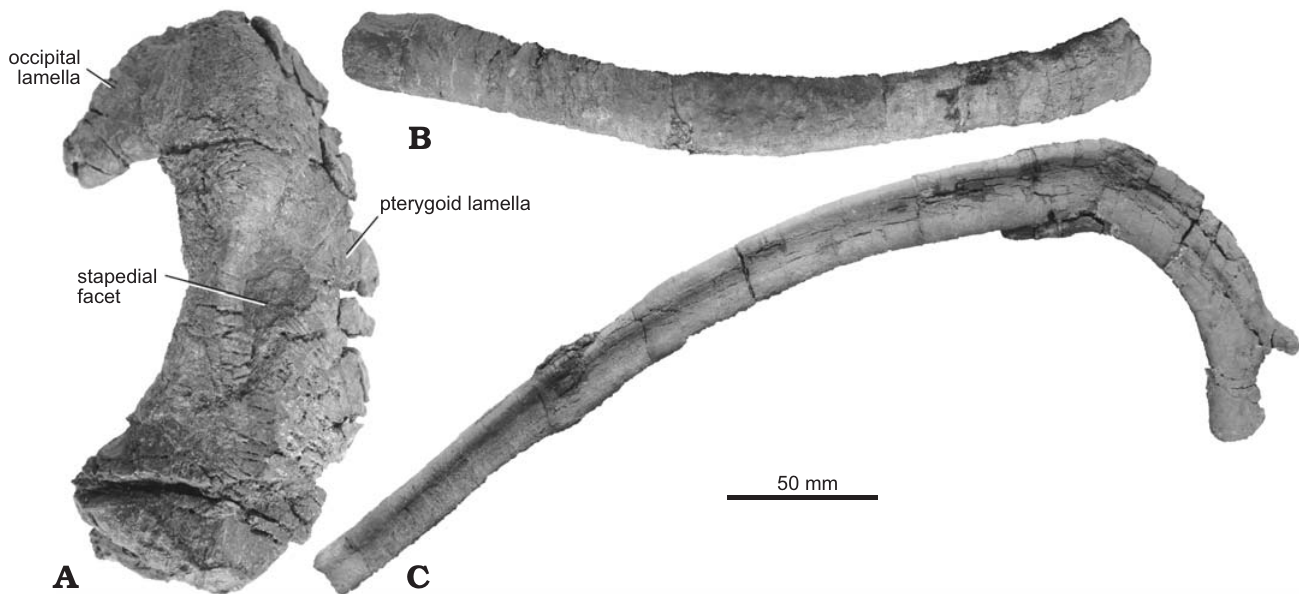
Fig. 9. Elements of Ophthalmosauridae indet. ( PMO 224.252) from Spitsbergen, Svalbard, Slottsmøya Member Lagerstätte, Tithonian. A . Left quadrate in posterior view. B . Hyoid in anterior or posterior view. C . Rib in anterior or posterior